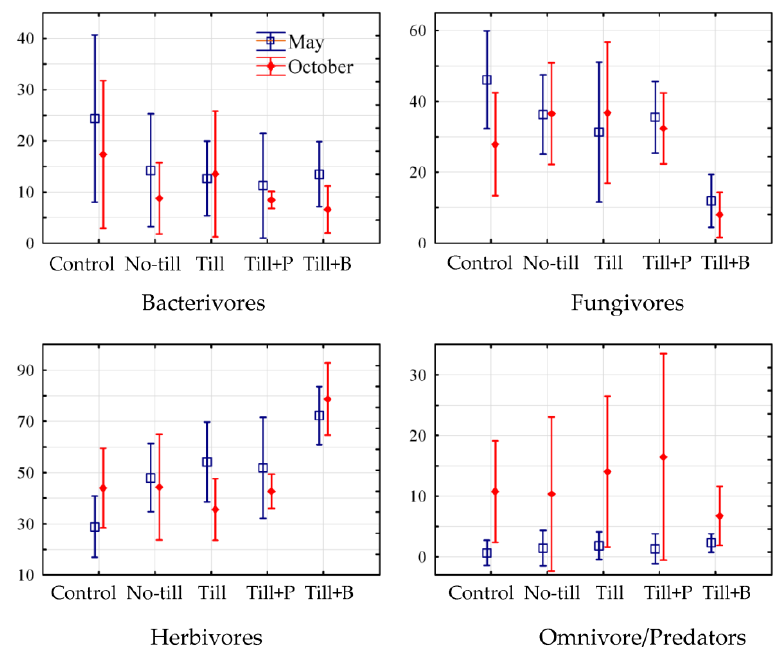
Figure 2. Proportion of the trophic groups in the nematode communities (in %, mean and 95% confidence intervals) as a response to different treatments.